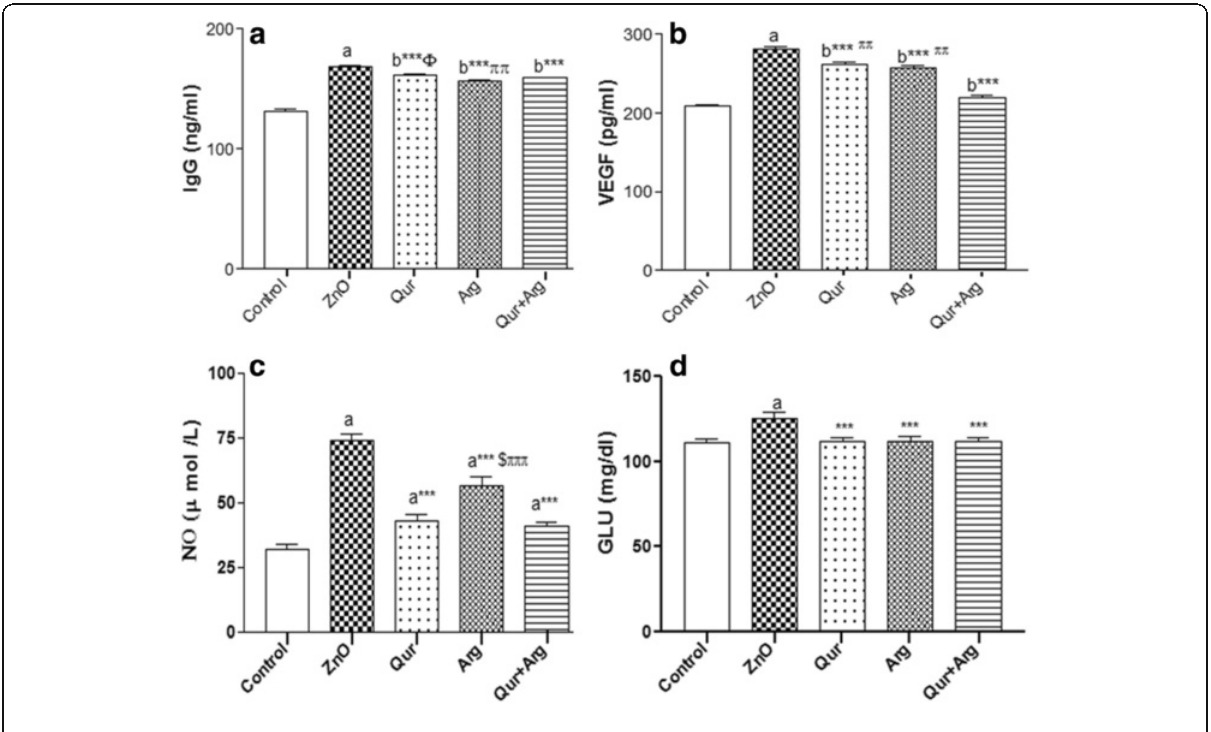
Figure 3 Effect of Qur and/or Arg treatment on renal glutathione level in intoxicated rats with a low dose of n-ZnO particles. Values are expressed as mean±S . D. a P < 0.001 compared with the normal control group, *** P < 0.001 compared with the n-ZnO-intoxicated group, πππ P ≤ 0.001, ππ P ≤ 0.01 compared with the combination group, using ANOVA followed by Bonferroni as a post-ANOVA